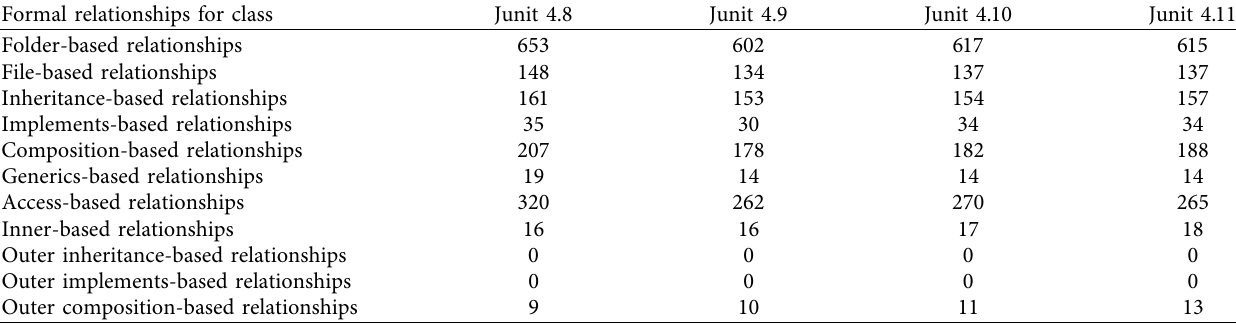
Table 18: Formal relationships for class in